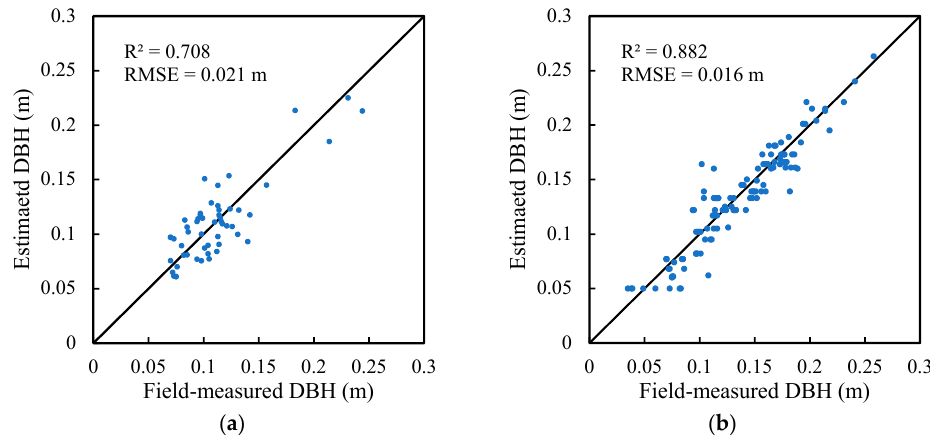
Figure 9. Scatter plots of field-measured DBH versus estimated DBH using all routes of ( a ) real UAV LiDAR data and ( b ) simulated UAV LiDAR data. Table 4. The accuracies of trunk point extraction and DBH measurement. Real Data Simulated Data